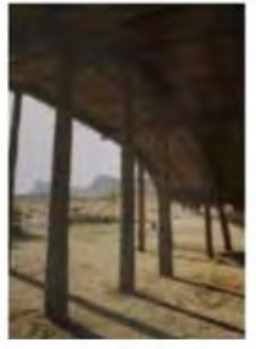
Figure 8. Interior Columns (Piesik, 2012)